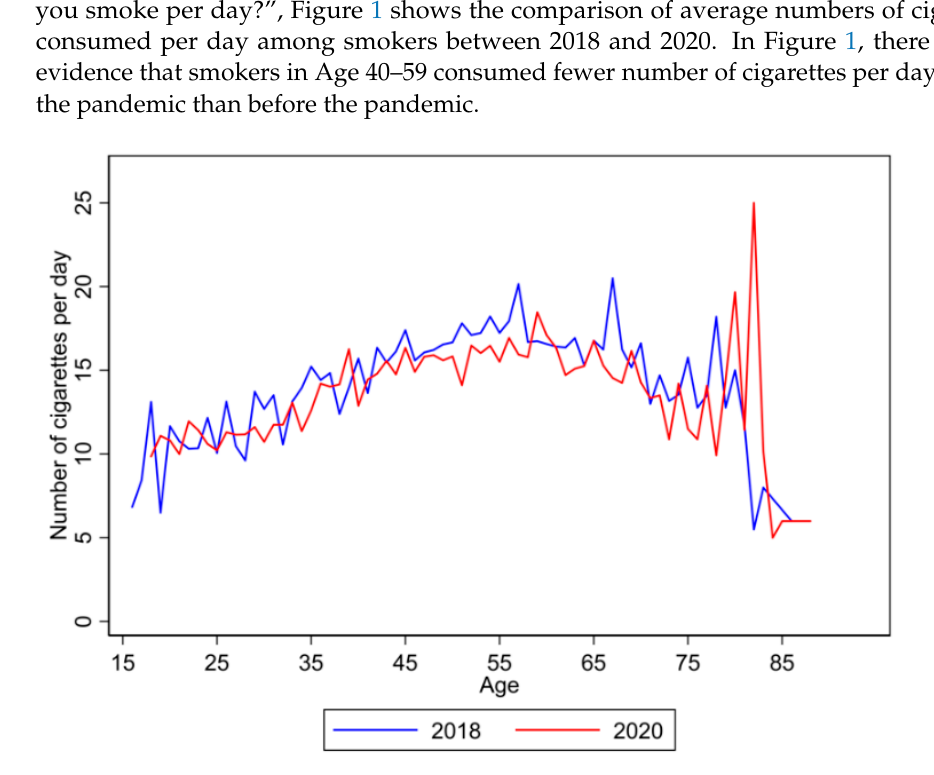
Figure 1. Comparison of number of cigarettes consumed per day among smokers between 2018 and 2020.